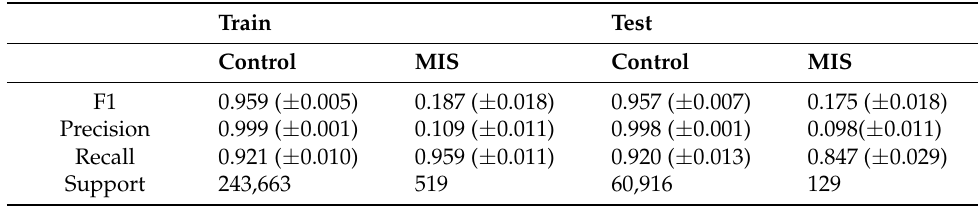
Table A1. Neural network performances.